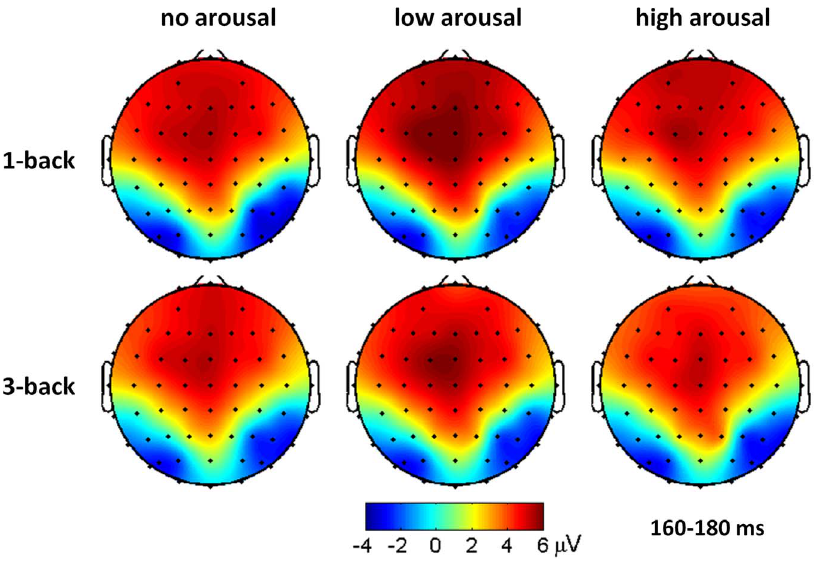
Figure 3. Grand average ERP topographies of the occipito-temporal N1 and fronto-central P2 components across different conditions.